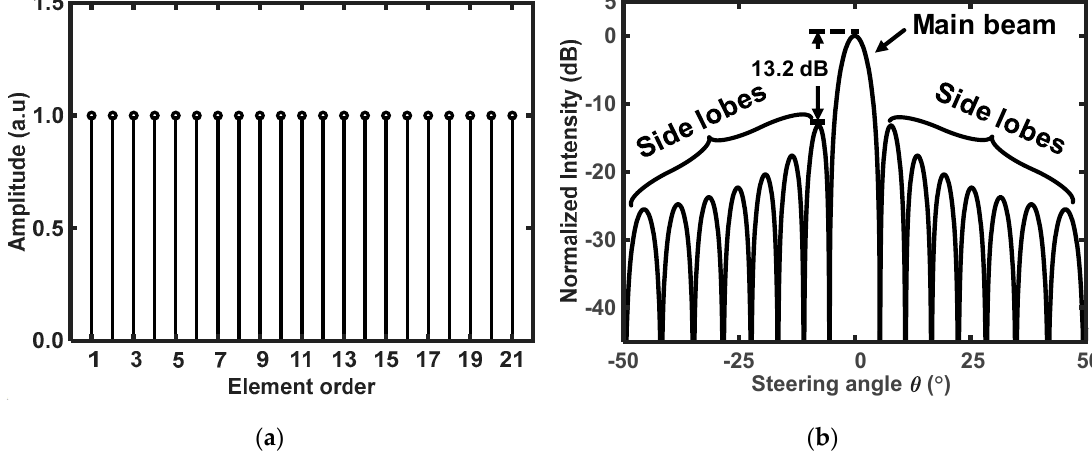
Figure 3. ( a ) Distribution of the rectangular window functions of 21 OPA elements. ( b ) Fourier transform (plotted on a decibel scale) of the rectangular window functions of the 21 OPA elements.